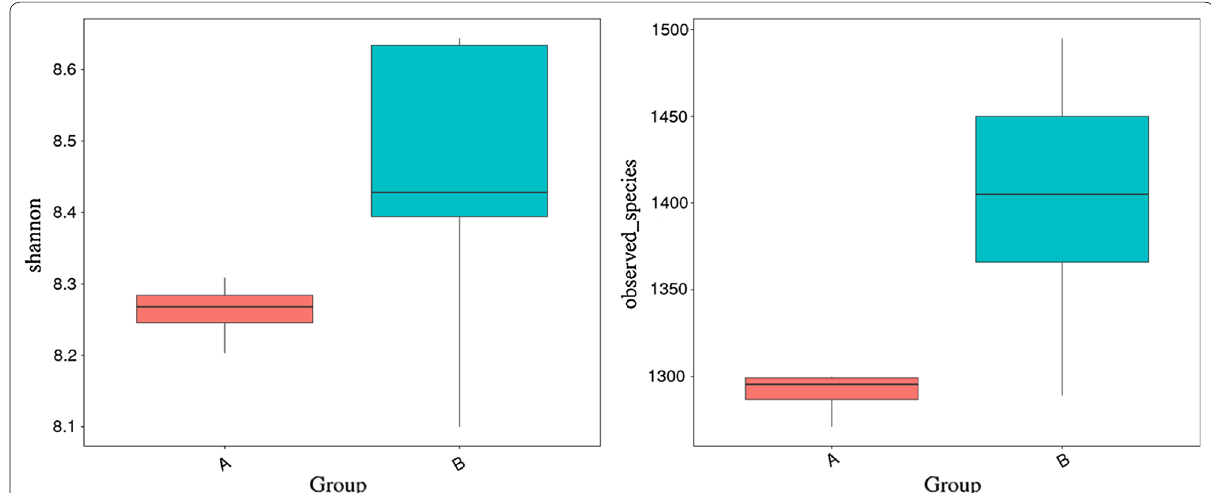
Fig. 2 A comparison of community alpha diversities between winter and spring samples in golden takins. Diversity was measured by calculating the Shannon index, and richness was determined by calculating the Observed-species